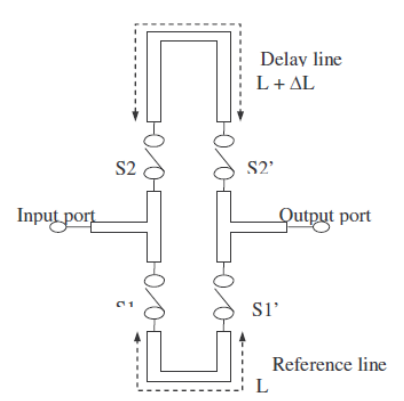
Figure 1: Geometry of the Phased-array system Table I: Truth table for 3-bit integrated phase shifter